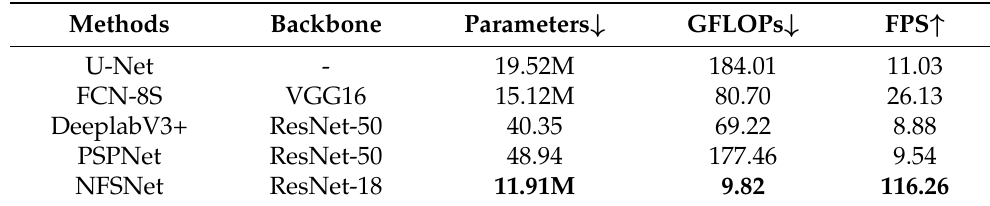
Table 5. Comparison of Parameters, floating point operations (FLOPs) and frames per second (FPS) of different networks. The highest values for the different metrics are highlighted in bold, ↑ means the higher the better, ↓ means the lower the